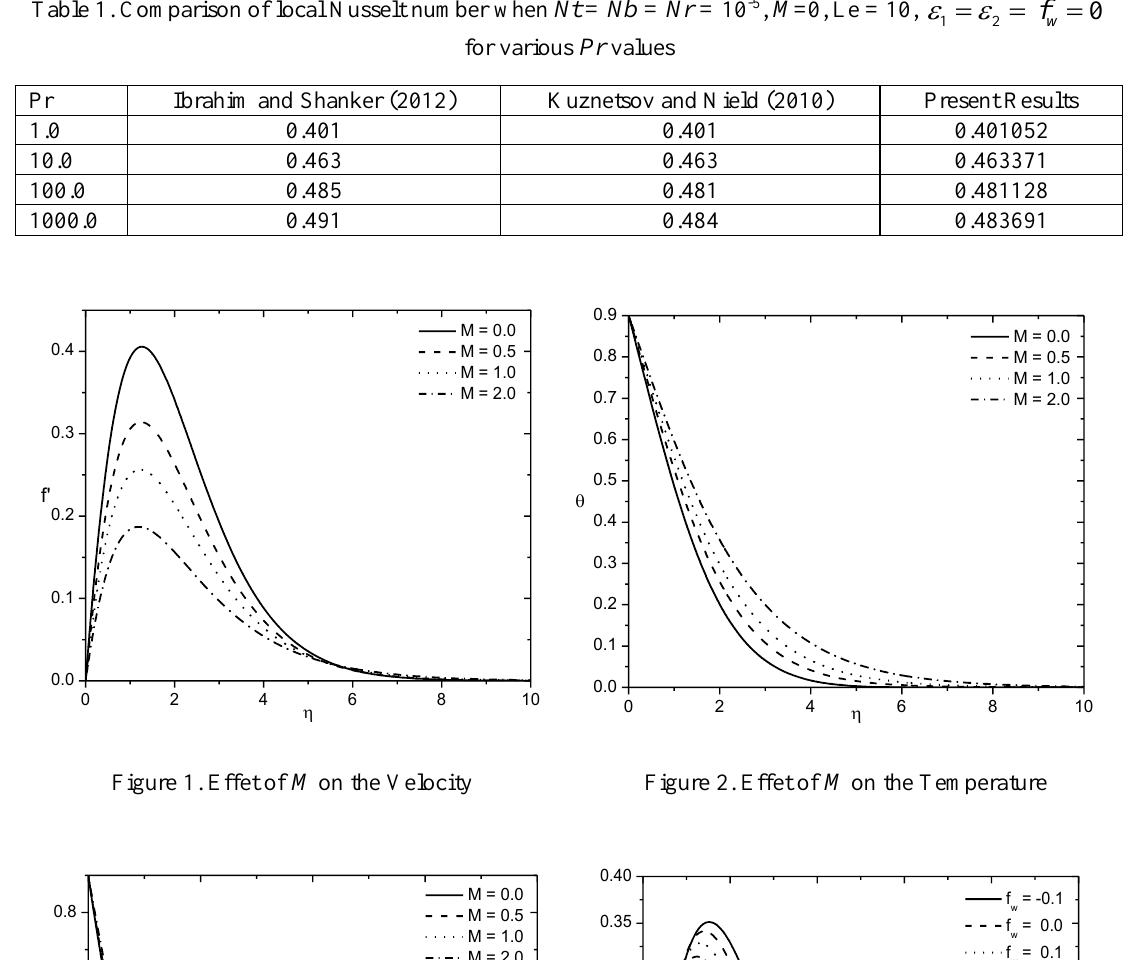
Table 1. Comparison of local Nusselt number when Nt = Nb = Nr = 10 -5 , M =0, Le = 10,